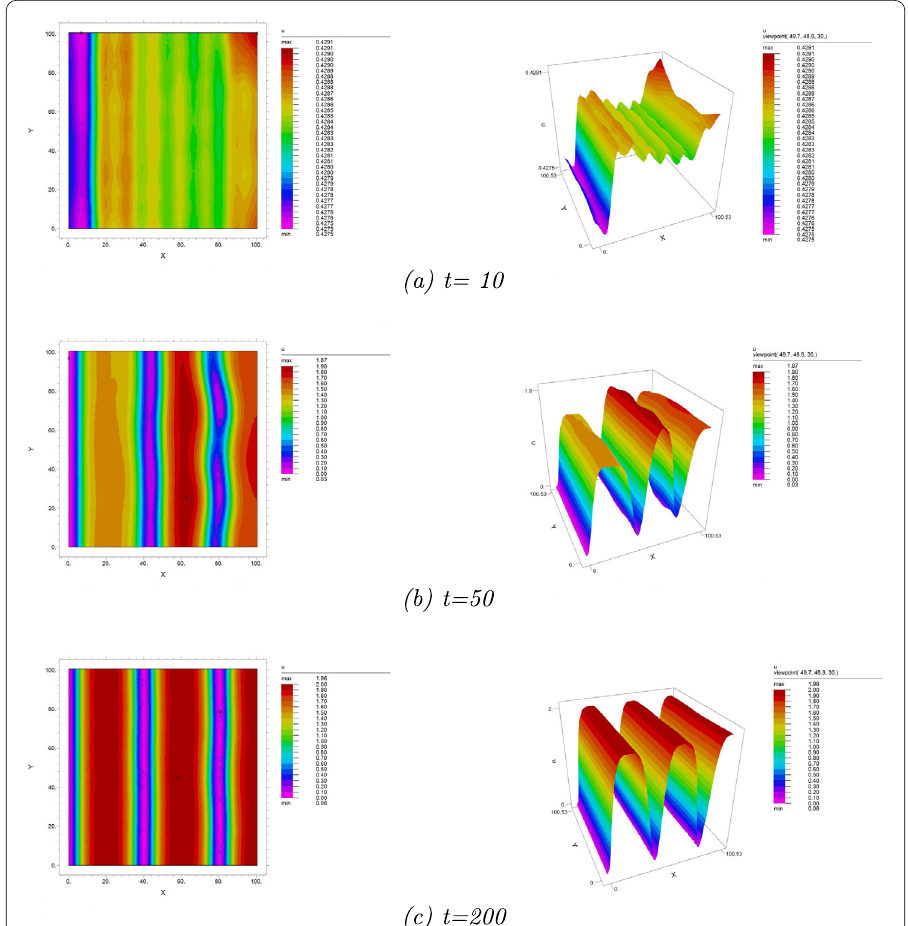
Figure 5 The process of Turing pattern for system (1.1) with parameters in (4.3), (4.4) and d = 0.5 > d 0 =